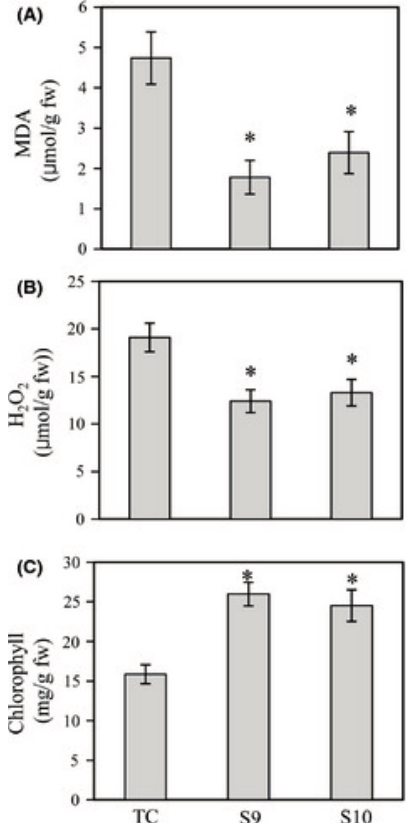
Figure 5. Levels of ( A ) lipid peroxidation products (malondialdehyde); ( B ) hydrogen peroxide (H 2 O 2 ); and ( C ) chlorophyll in butafenacil-treated rice seedlings containing normal melatonin levels (TC) and in transgenic rice seedlings containing elevated melatonin concentrations (Supplementary S9 and S10). Higher melatonin levels reduced lipid peroxidation and H 2 O 2 production and elevated chlorophyll levels. * p < 0.05 versus TC. From Park et al. [141] with